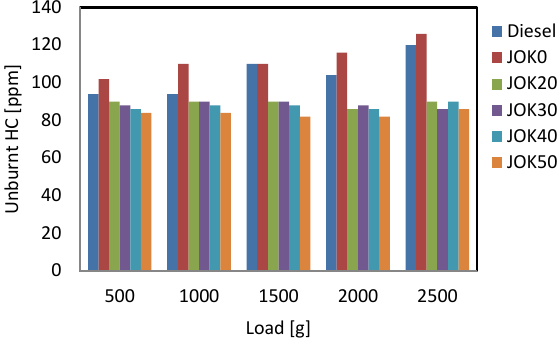
Fig. 10. Variation of UHC for JOK blends with increase in